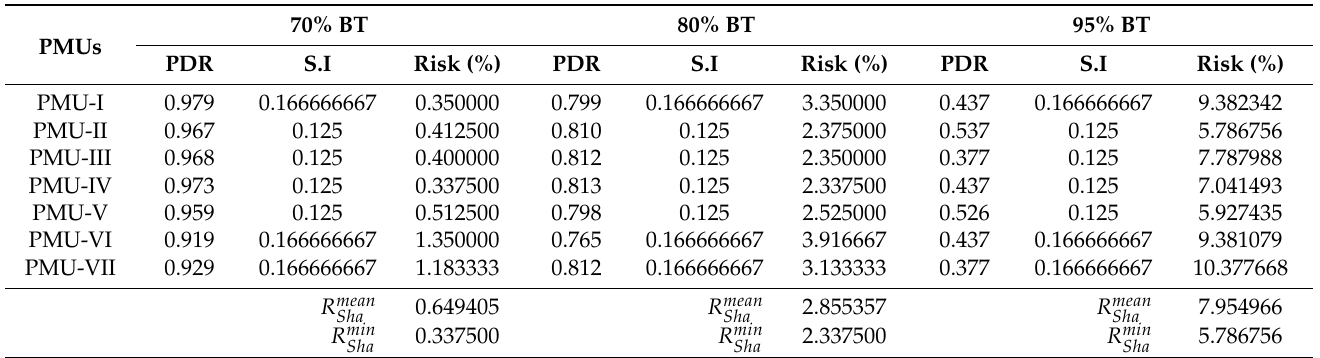
Table 5. Simulation results of shared SCN with 300 Kbps data rate under varying